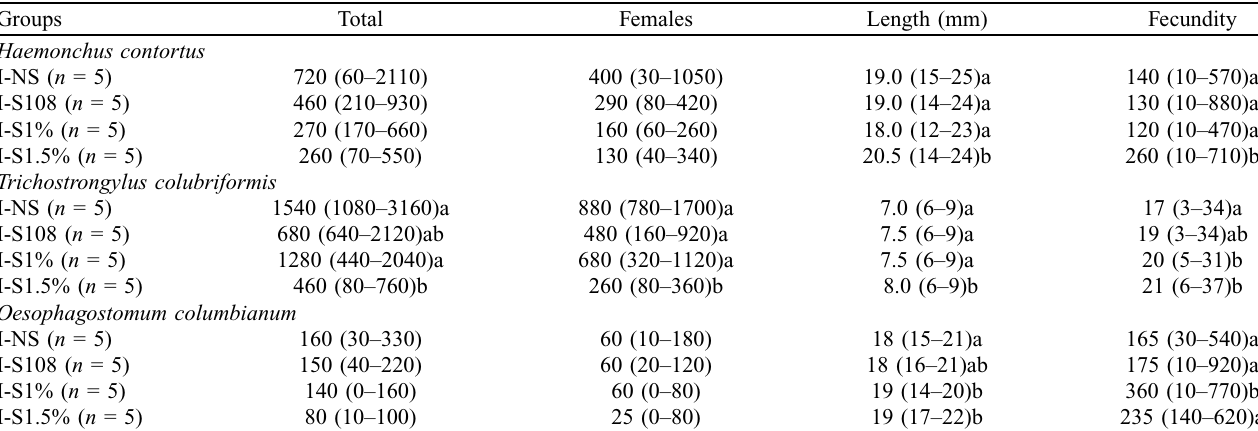
Table 4. Median (minimum – maximum) number of adult parasites (total and females) recovered in the different sections of the gastrointestinal tract of browsing kids supplemented with different levels of maize grain during the rainy season and the respective median length of adult female worms and median number of eggs in utero (minimum –